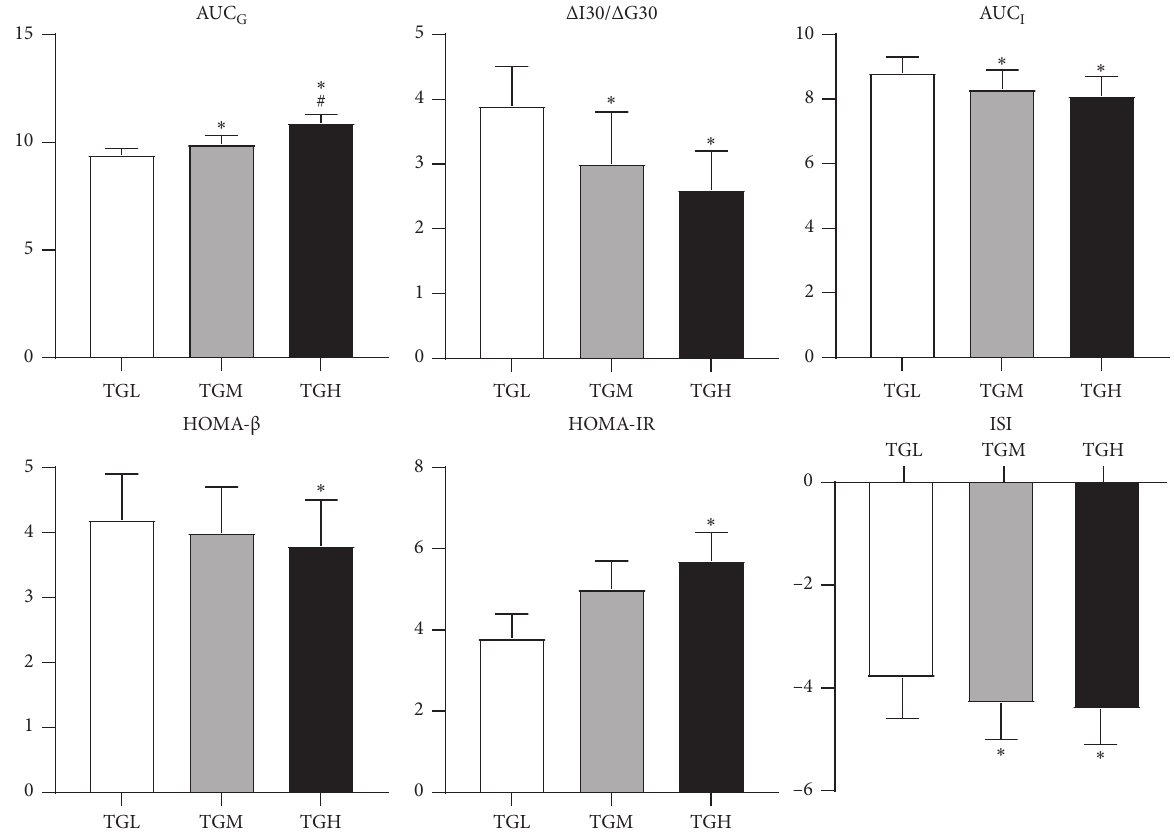
Figure 2: Islet β -cell function and AUCG among patients with different HbA1c levels. TGL: TG < 1.7mmol/L; TGM: TGM 1.7 ≤ TG < 2.3mmol/L; and TGH: TG ≥ 2.3mmol/L. AUC G : area under the curve of glucose; Δ I glucose increment 30min after glucose load; AUC I : area under the curve of insulin; HOMA- β : homeostasis model assessment of β -cell function; HOMA-IR: homeostasis model assessment of insulin resistance index; and ISI: insulin sensitivity index. ∗ P < 0 . 05 versus TCL; # P < 0 . 05 versus TCM.